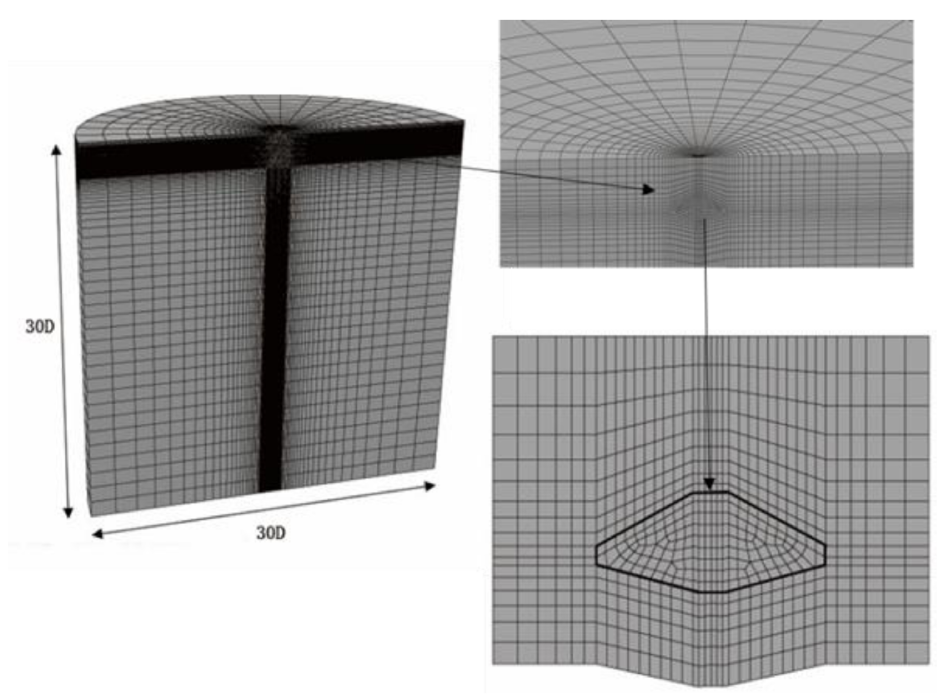
Figure 2. Finite element model for a typical SSFE (small-strain finite element) computation